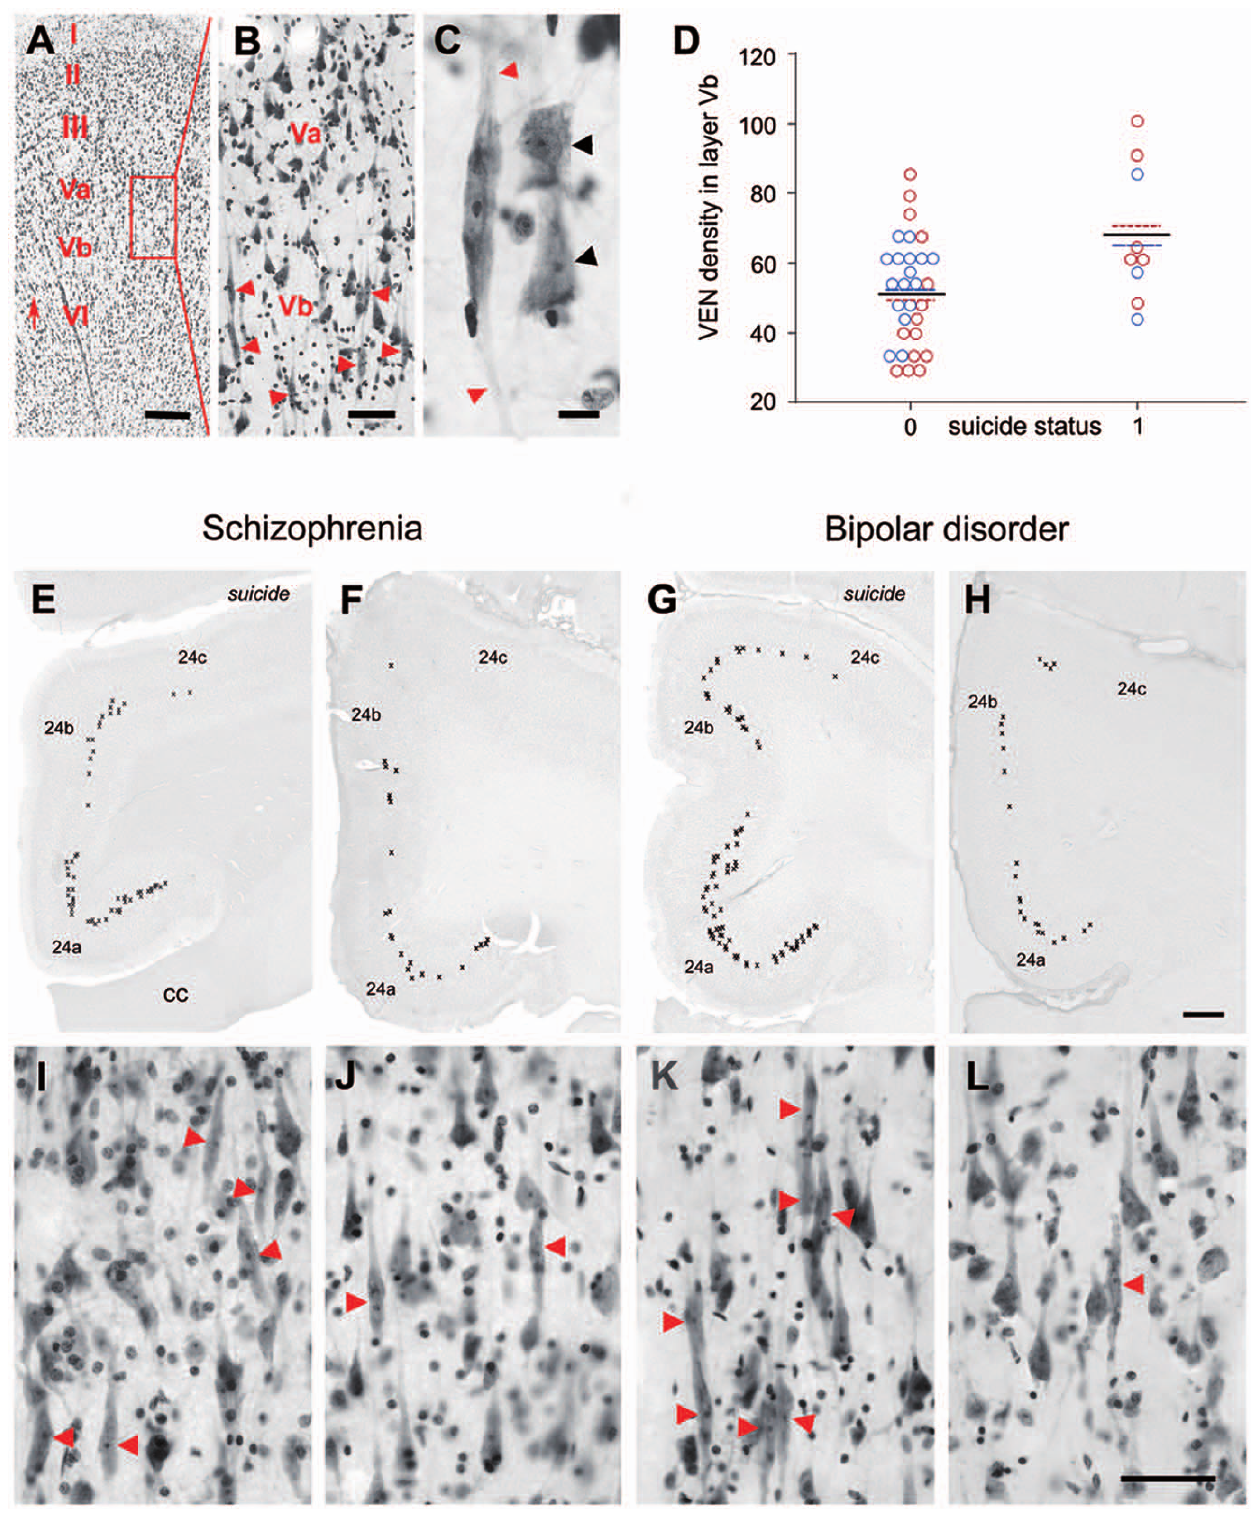
Figure 1. The localization and distribution of VENs in the ACC of suicide victims and non-suicide subjects. (A) Cresyl violet stained section displays the cortical layers I, II, III, Va, Vb and VI of the anterior cingulate cortex (ACC). (B) Numerous von Economo neurons (VENs, arrowheads) are localized in layer Vb, adjacent to layer Va, where large pyramidal cells are frequent. (C) The VENs (for localization see arrow in A) with elongated somata and bipolar dendrites (red arrowheads) can easily be distinguished from neighbored triangular-shaped pyramidal cell somata (black arrowheads). (D) VEN density in the ACC of suicide victims and non-suicide subjects with psychosis (values for the right ACC are shown in red, values for the left ACC are marked in blue; black: total values; ‘‘0’’ indicates no suicide, ‘‘1’’ indicates suicide cases). The representative distributions of